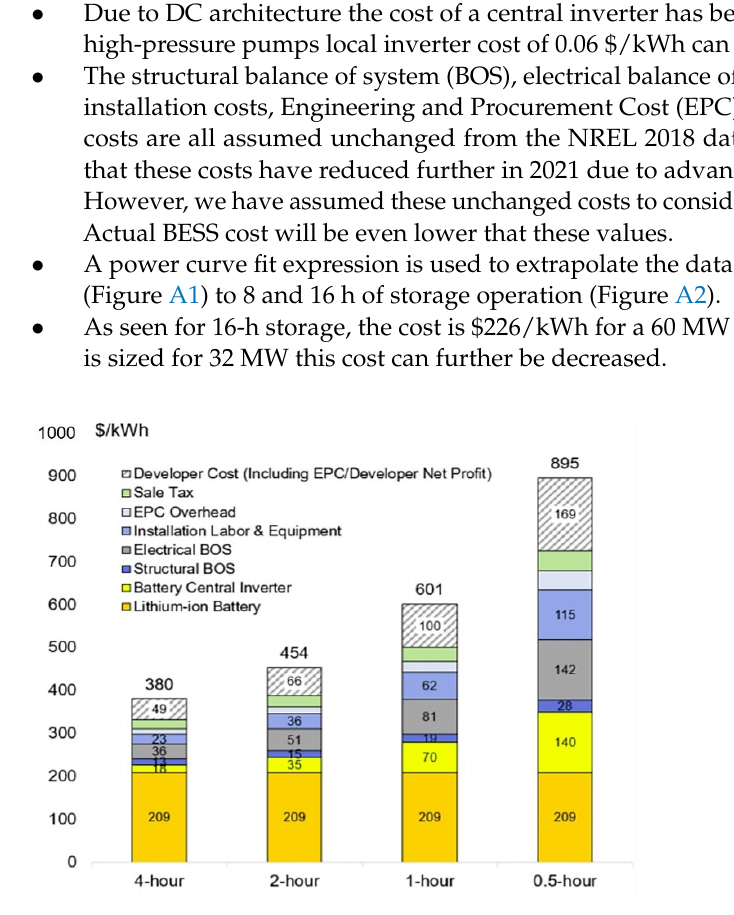
Figure A2. Battery storage costs from NREL and extrapolated costs for 8 and 16 h operation of the battery energy storage system (BESS) [68]. Appendix C The amortized amount payable for every installment is taken from reference [70]: Amortized amount of each monthly payment ( A ) = P × {( I × (1 + I ) n )/(1 + I ) n − 1}